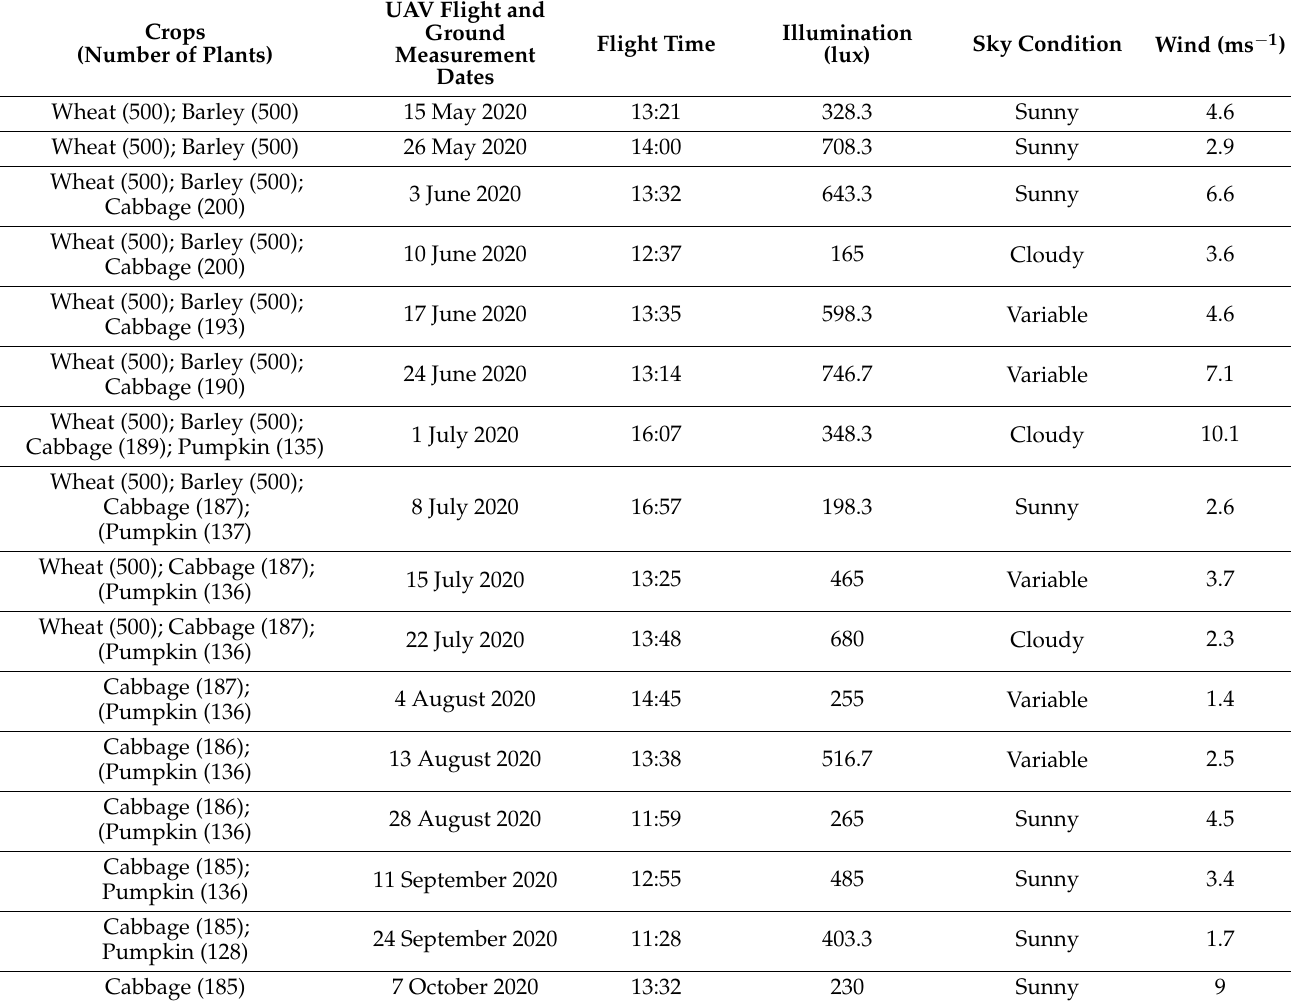
Table 1. UAV acquisition and ground truth measurement details observed for the experimental strip cropping field of the Droevendaal organic experimental farm in Wageningen, the Netherlands for 2020. The numbers in the first column refer to the number of field measurements per crop